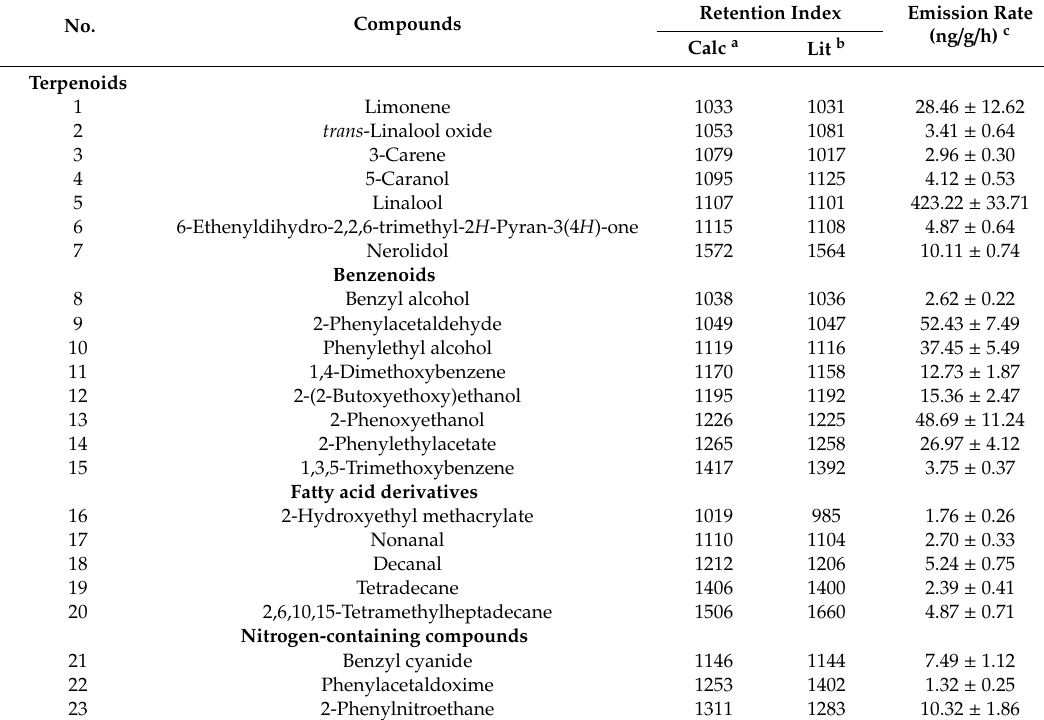
Table 1. The major volatile compounds identified in the full flowers of Clematis florida ‘Kaiser’.